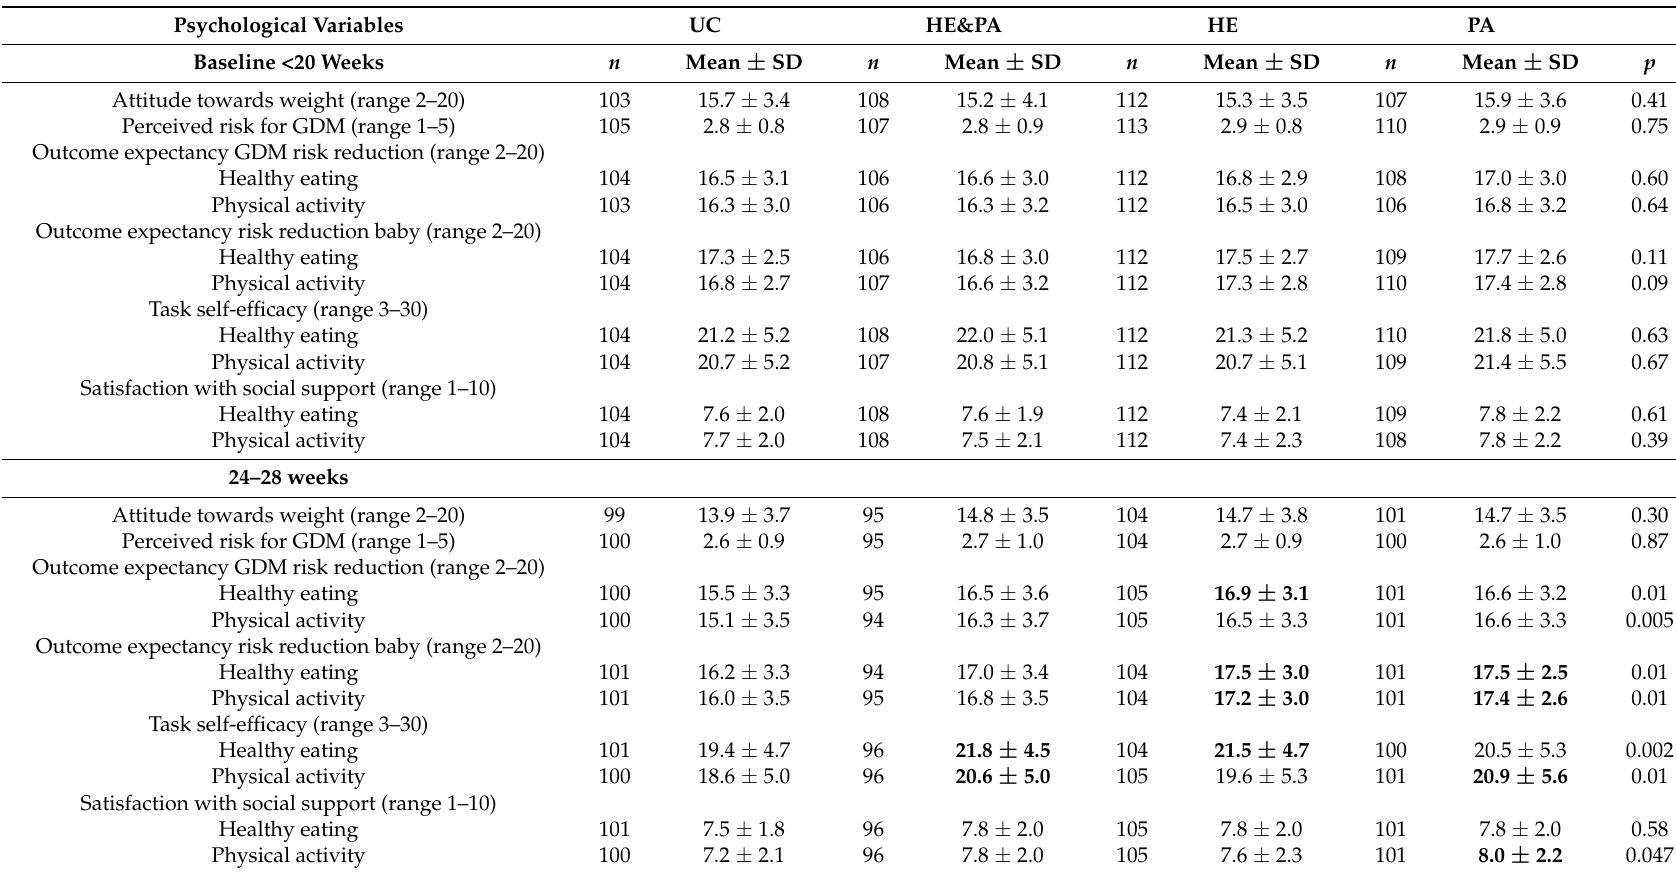
Table 2. Potential mediators and lifestyle outcomes per intervention group at all three time